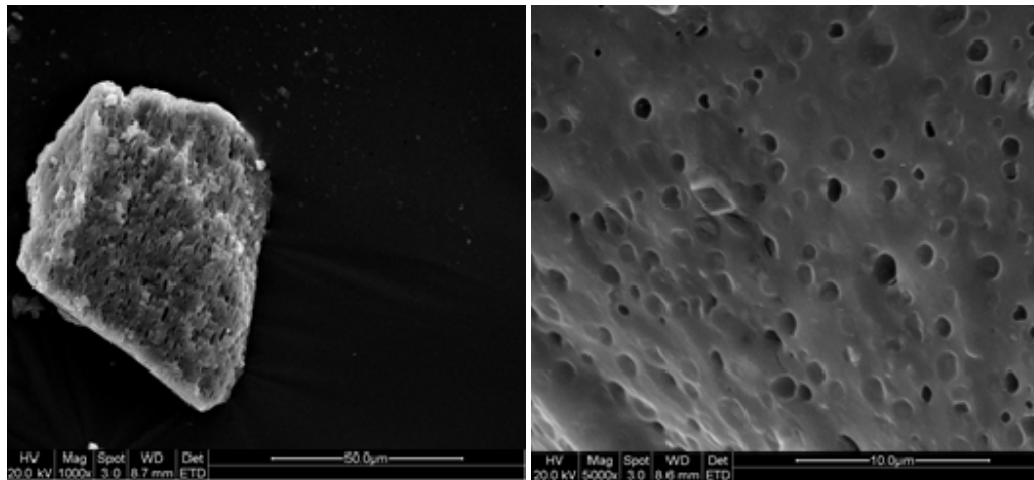
Figure 2. S canning electron microscopy (SEM) images for FeCl different magnification.